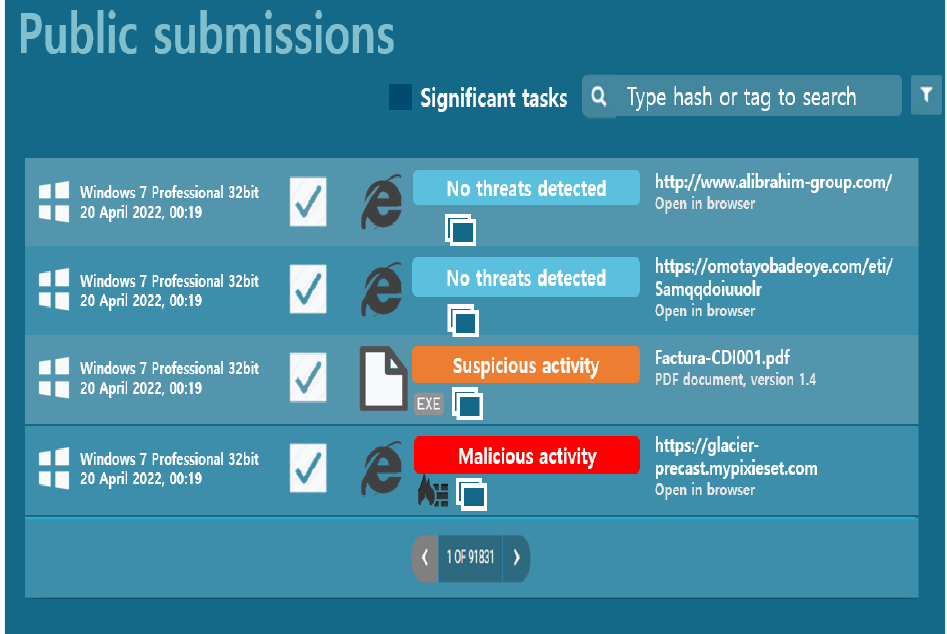
Figure 12. Classification of malicious and normal files by operating system.